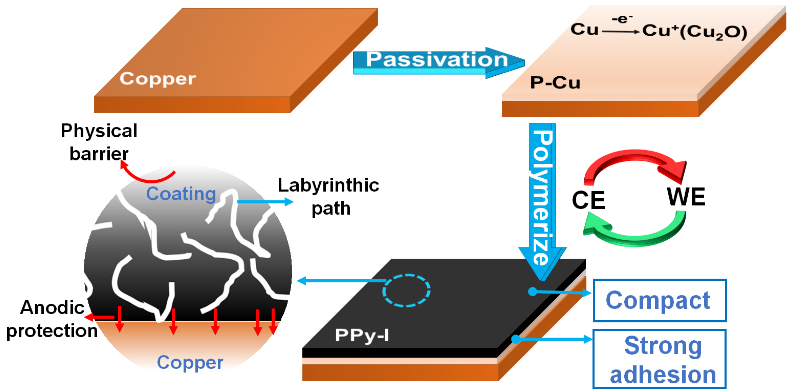
Figure 1. Schematic flowchart for electropolymerizing PPy coatings on copper surface with high corrosion resistance by the inverted electrode strategy (P-Cu: passivated copper; PPy-I: PPy coating obtained by the inverted-electrode strategy).